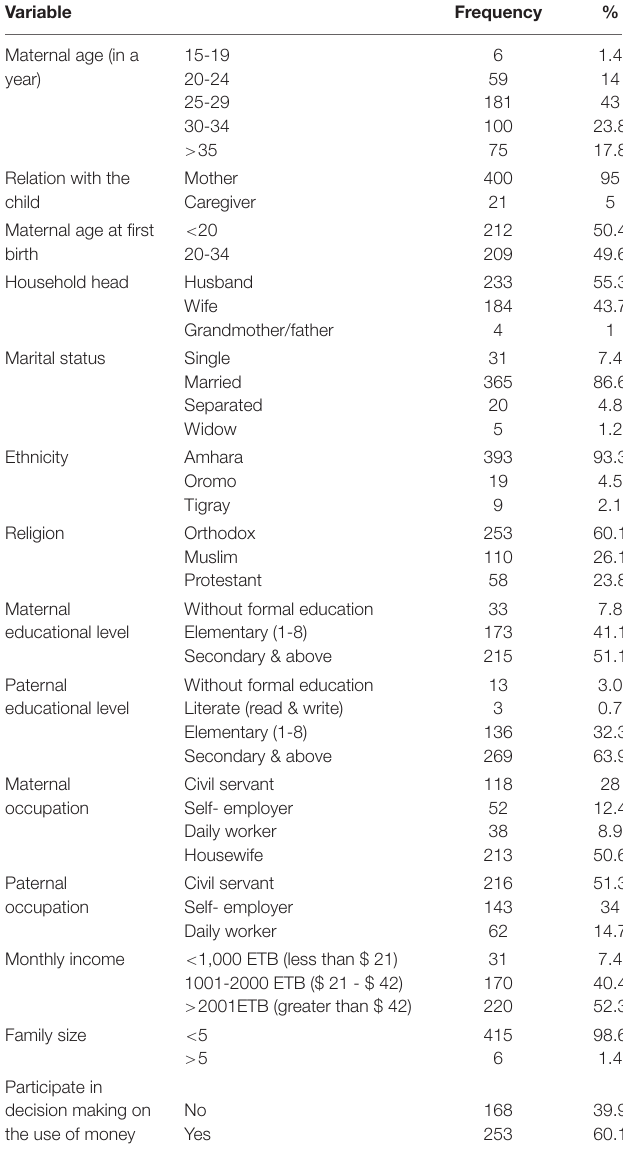
TABLE 1 | Sociodemographic characteristics of the study participants, Dessie Town, South Wollo Zone, Northeastern Ethiopia, 2021.